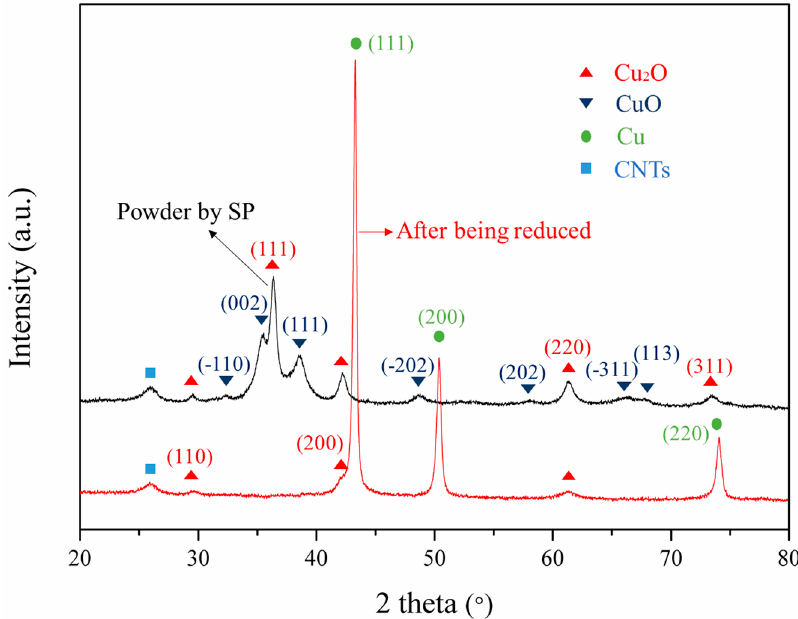
Figure 3. XRD patterns of the obtained composite powder by SP and after being reduced under an H 2 atmosphere.